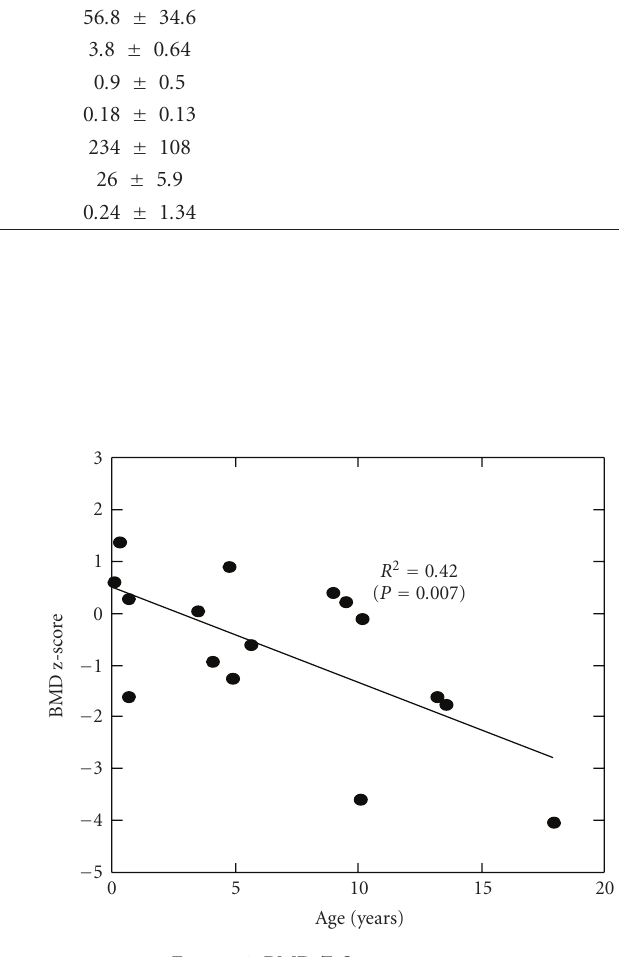
Figure 1: BMD Z -Score versus